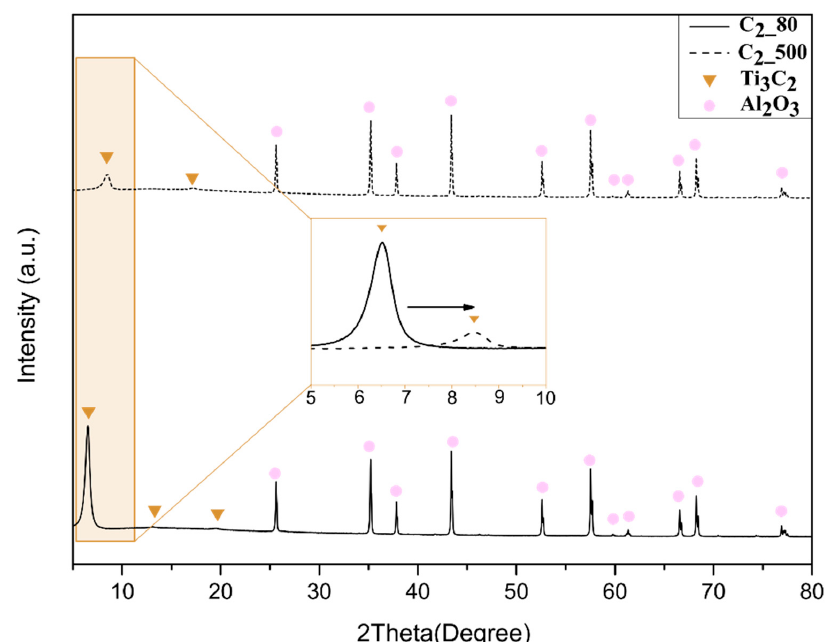
Figure 4. XRD patterns of Al 2 O 3 substrates coated with Ti 3 C 2 by dip coating using suspension C 2 treated at 80 °C under vacuum and 500 °C under H 2 /Ar atmosphere.